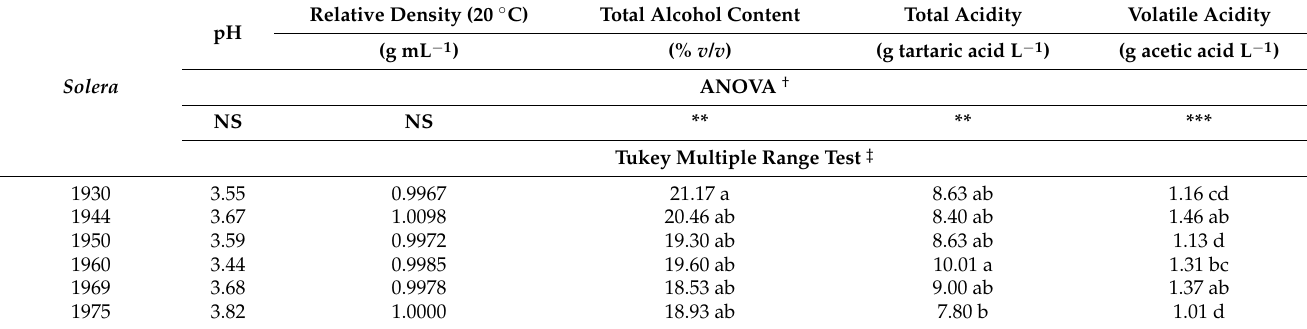
Table 1. Basic enological parameters of Fondill ó n wines as affected by the “ solera ” factor.